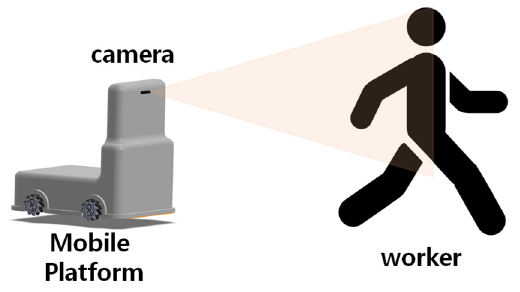
Figure 1. Fiducial marker-based worker-following control system.